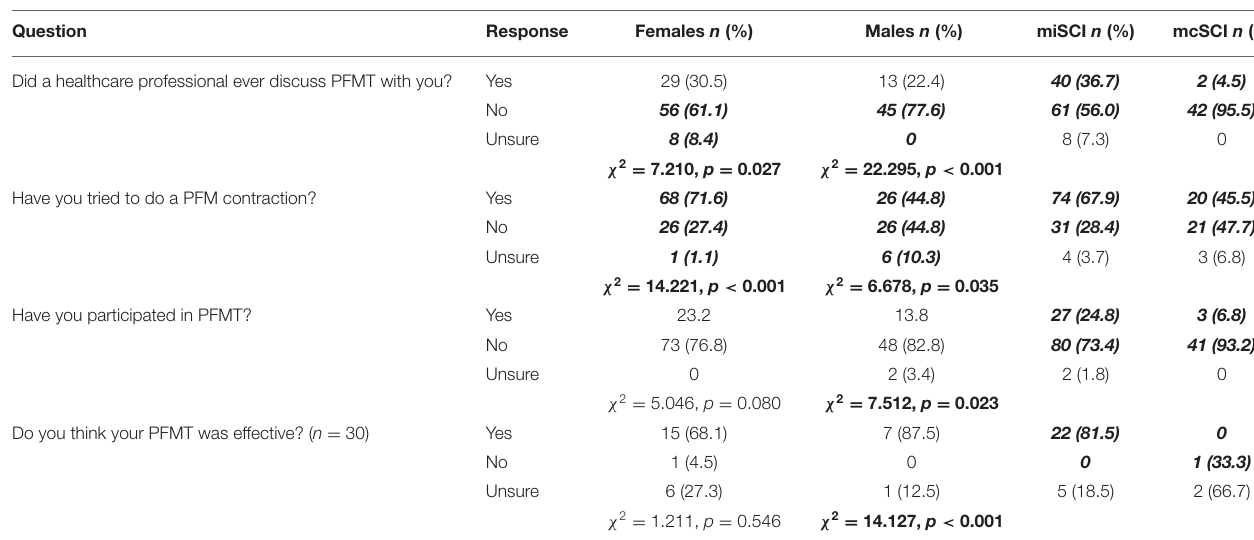
TABLE 3 | Practice results by sex and degree of motor